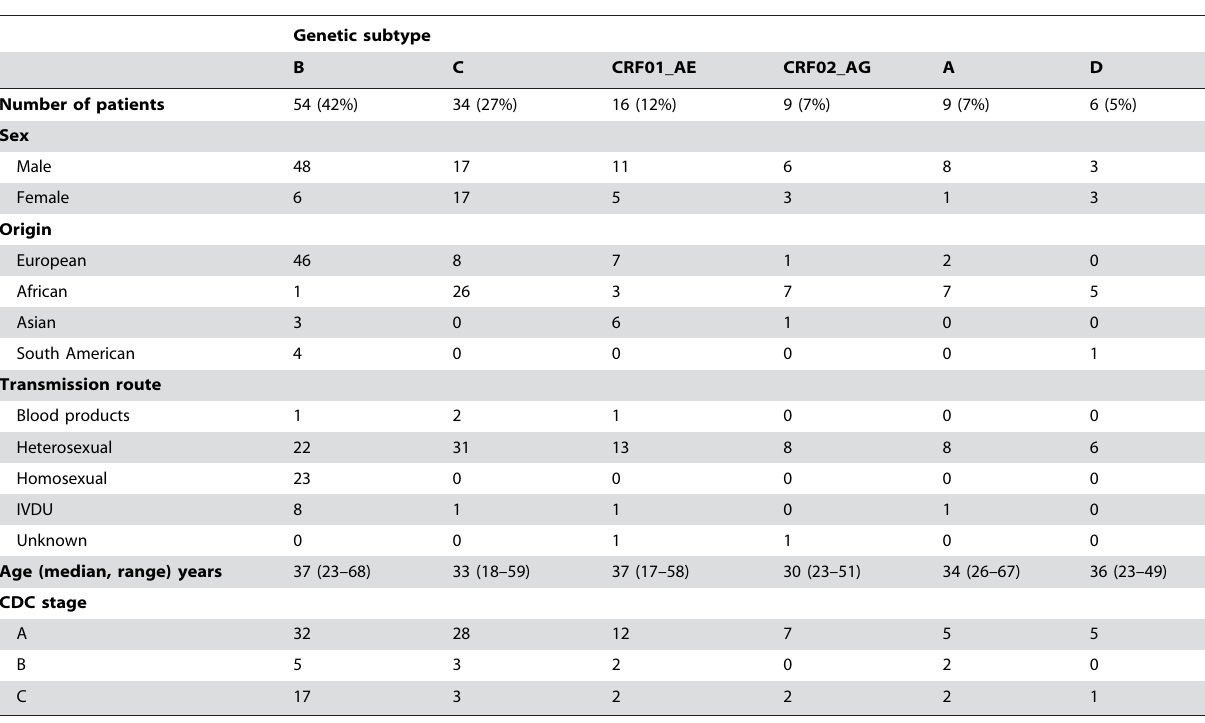
Table 1. Demographic and clinical characteristics of the study